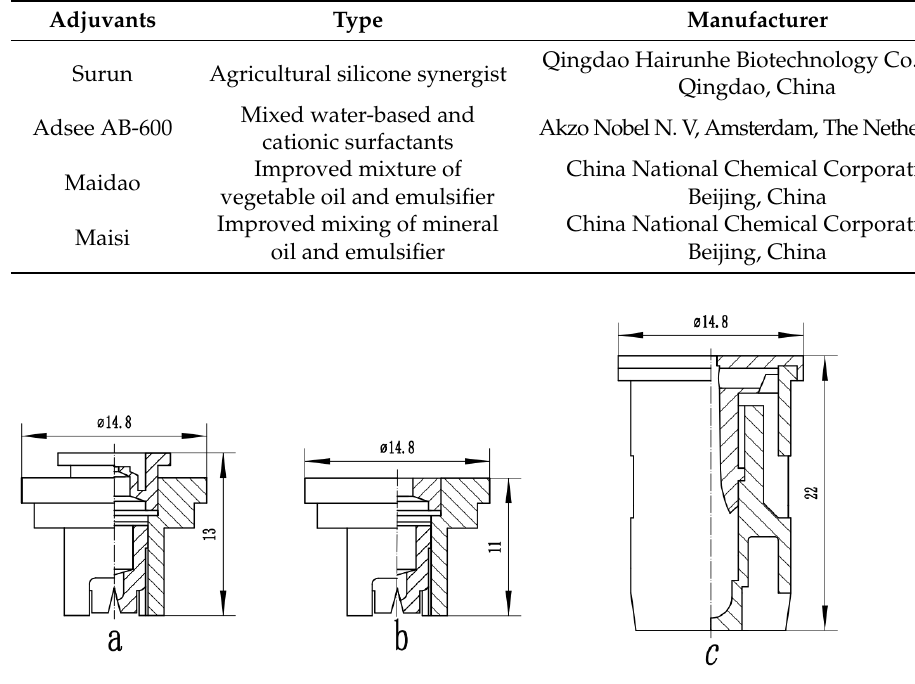
Figure 1. Diagram of nozzle structure (( a ) LU120-03, ( b ) AD120-03, ( c )